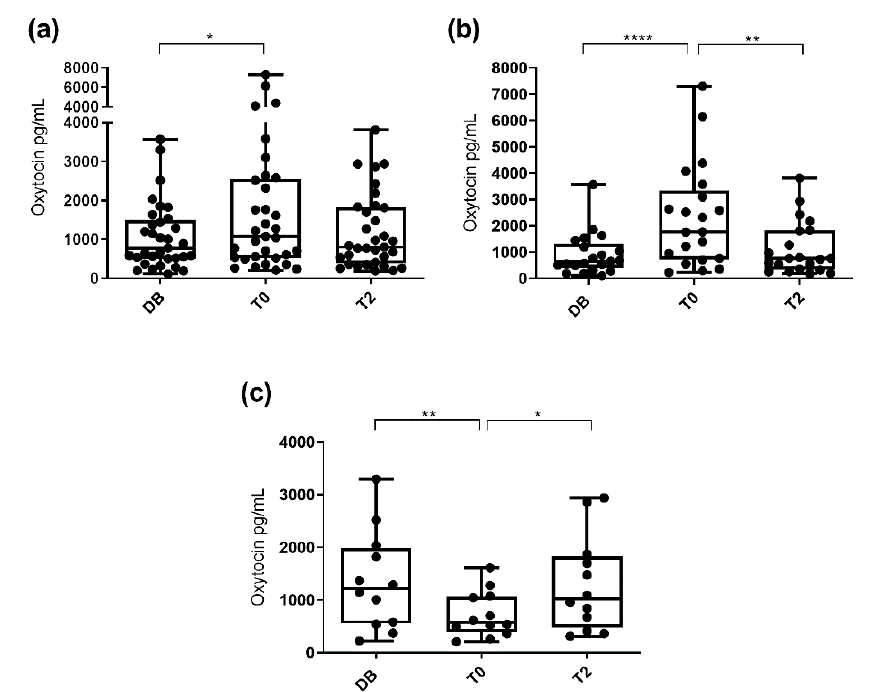
Figure 1. Changes in salivary oxytocin concentrations measured with AlphaLISA monoclonal assay at different times: the day before ejaculate collection (DB), immediately after starting the ejaculation (T0) and two hours after ejaculation (T2). Data for all 33 boars ( a ), data for the 21 boars showing increased oxytocin concentration at ejaculation time ( b ) and data for the 12 boars that did not show increased oxytocin concentrations at ejaculation time ( c ). The plots show medians (line within box), 25th and 75th percentiles (boxes), min and max values (whiskers) and individual data points. Asterisks indicate differences between times (**** p ≤ 0.0001; ** p ≤ 0.01; * p ≤ 0.05).